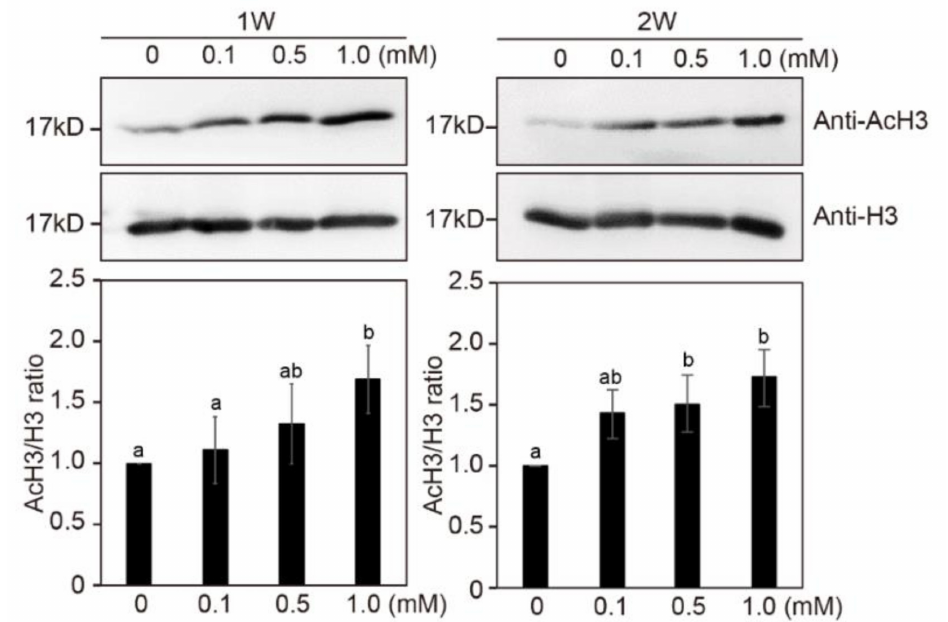
Figure 7. The e ff ect of sodium butyrate on histone H3 acetylation level in tobacco protoplast-derived calli. Total protein extracts were obtained from protoplast-derived calli of tobacco after 1 or 2 weeks after NaB treatments. Error bars represent SD ( n = 3). Histone acetylation levels were determined with a western blot using an anti-H3 and anti-AcH3 antibody. Di ff erent letters on the bars indicate significant di ff erences between each treatment (ANOVA followed by a Turkey’s test, p < 0.05). W = week(s); H3 = histone H3 antibody; AcH3 = acetylated histone H3